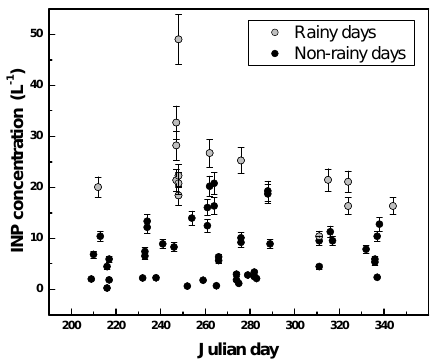
Figure 2. Data of INP concentrations measured throughout the pe- riod